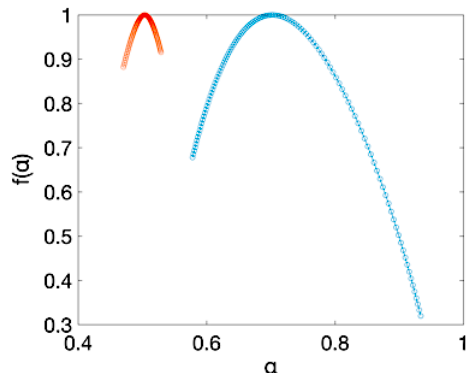
Figure 6. Multifractal spectra for the original (right) and for the shuffled (left) time series. The plots are for the closest to Thessaloniki grid point (40.50 ° N, 23.25 ° E).